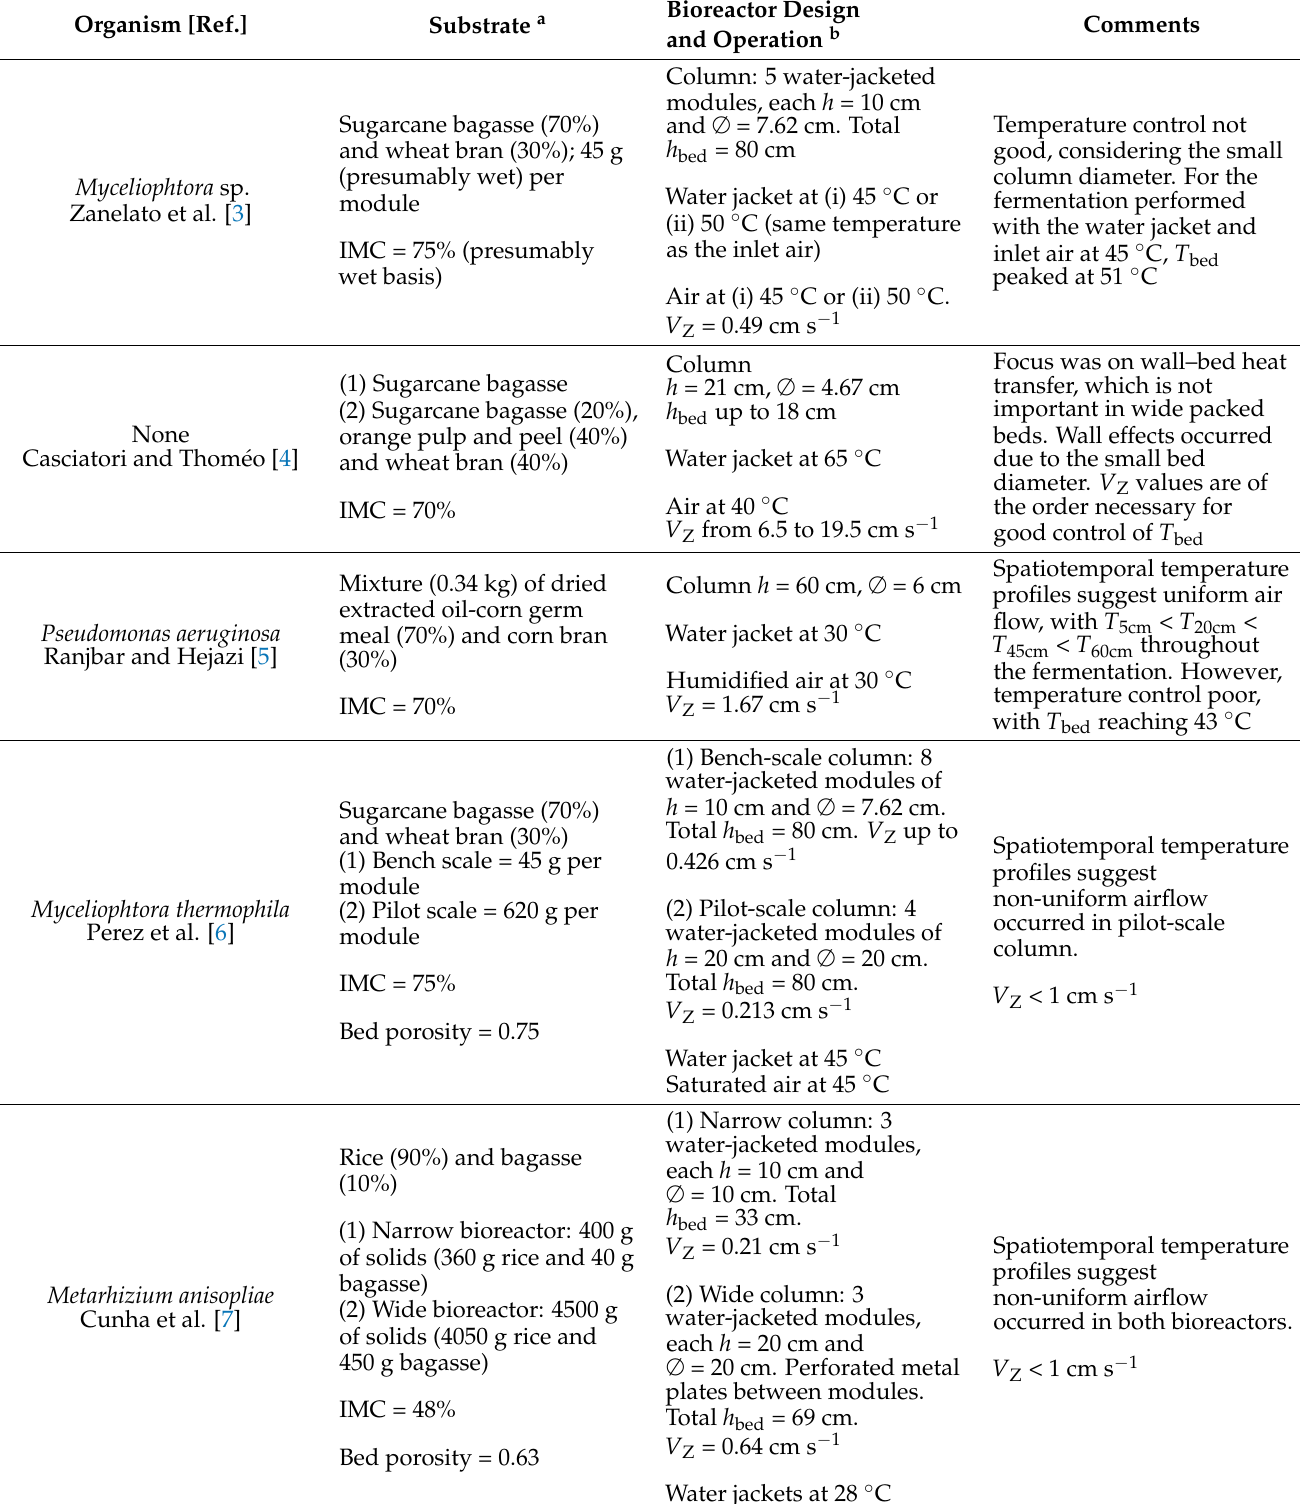
Table 1. Studies conducted in jacketed packed-bed bioreactors with the aim of guiding scale-up. Organism